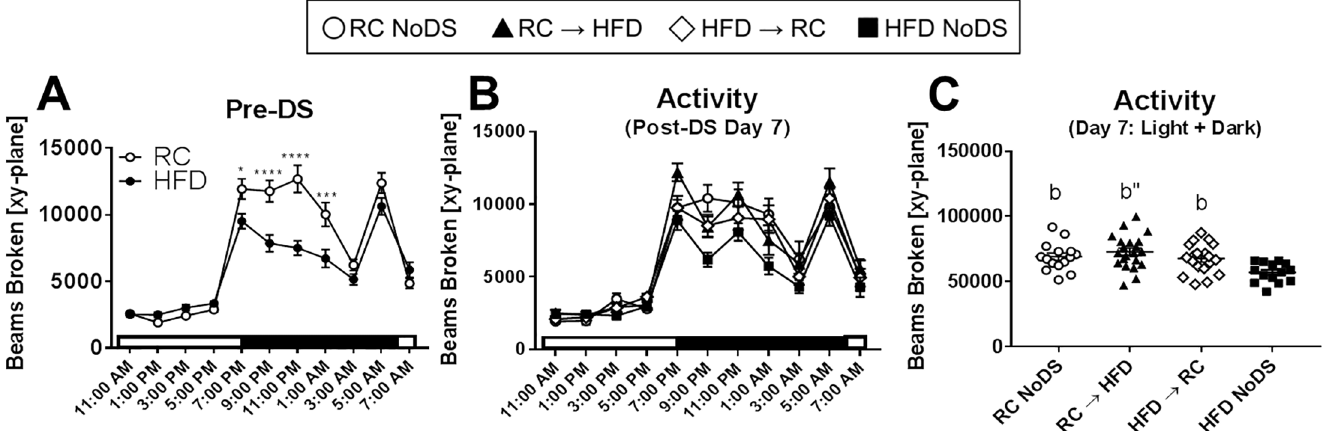
Fig 2. Spontaneous locomotor activity is only reduced in HFD NoDS compared to all other conditions. (A) Pre-DS locomotor activity shows HFD-fed mice are less active compared to RC-fed controls. (B) Locomotor activity counts in 2-hour time bins on Day 7 Post-DS. (C) Aggregate (24-hour) locomotor activity counts Day 7 Post-DS. All conditions are significantly more active than HFD NoDS. Note that body weight and food intake were measured daily between 9–10 am (ZT2-3), so locomotor data are omitted during the ZT2-4 time window. (cid:3) p < 0.05, (cid:3)(cid:3)(cid:3) p < 0.001, (cid:3)(cid:3)(cid:3)(cid:3) p < 0.0001 comparing RC v HFD at indicated time point; b: p < 0.05, b”: p < 0.001 compared to HFD NoDS. RC NoDS, n = 15; RC ! HFD, n = 21; HFD ! RC, n = 19; HFD NoDS, n =